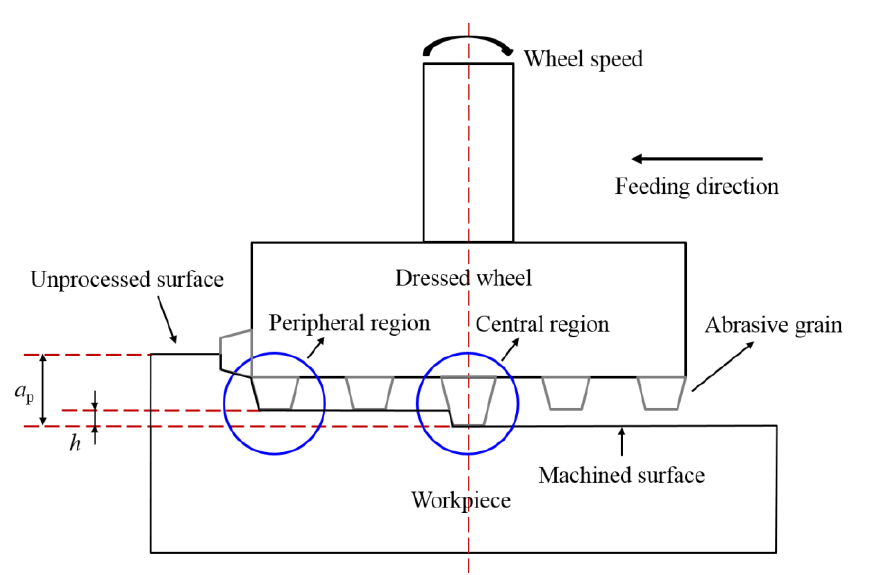
Figure 10. Schematic diagram of abrasive grits on the end face of the dressed grinding wheel.